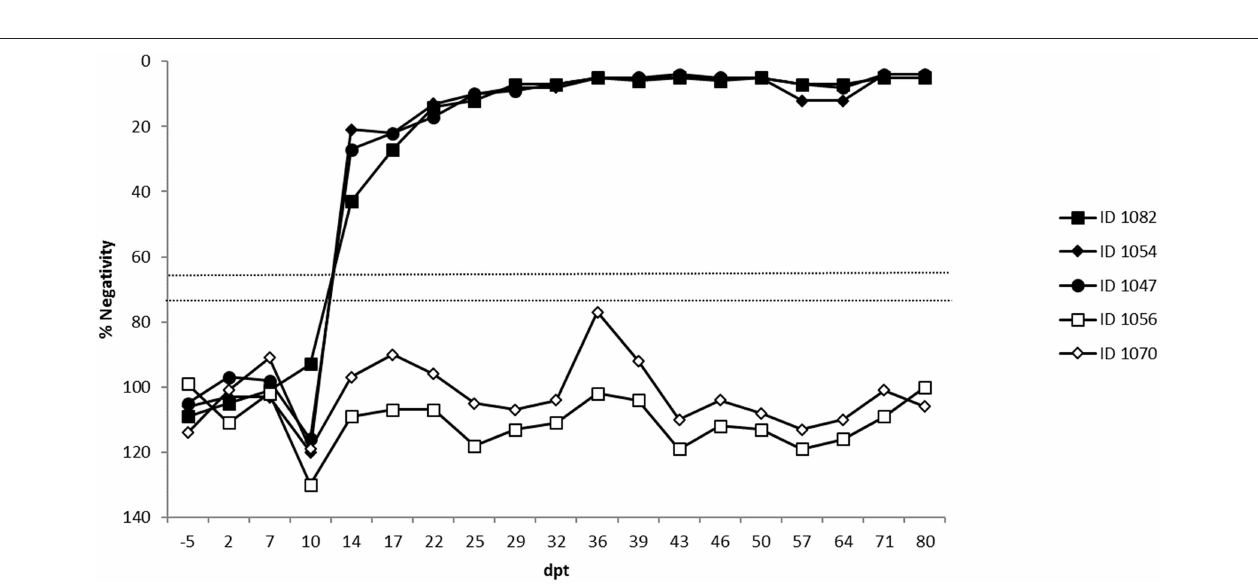
FIGURE 4 | ELISA results of the three recipient (1082, 1054, 1047) and 2 sentinel cows (1056, 1070). Percentage negativity (PN): positive PN ≤ 65, doubtful PN > 65 but ≤ 75 and negative PN > 75. Dpt, days post